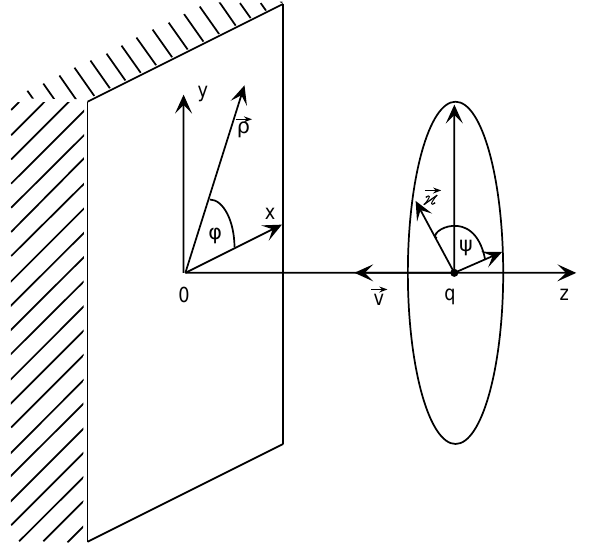
FIG. 1. The moving charge field can be represented by a set of pseudophotons whose wave vector transverse and longitudi- nal components are ˘ and v (cid:121) y , respectively. Transition radia- tion appears as a result of the interaction of pseudophotons with the conducting boundary.